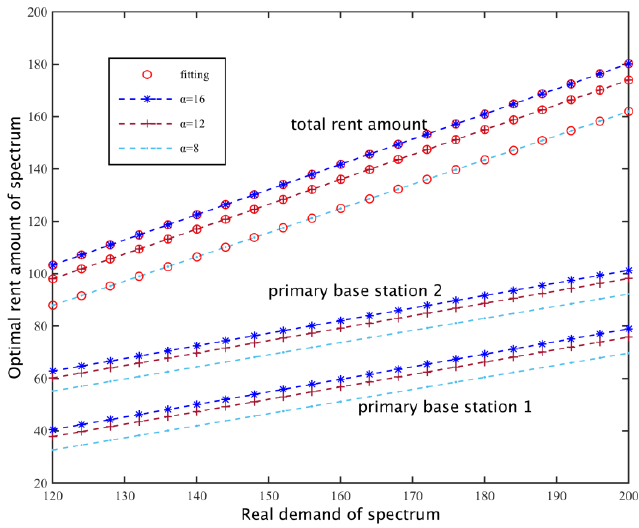
Figure 12. Secondary base station spectrum optimal rent number.